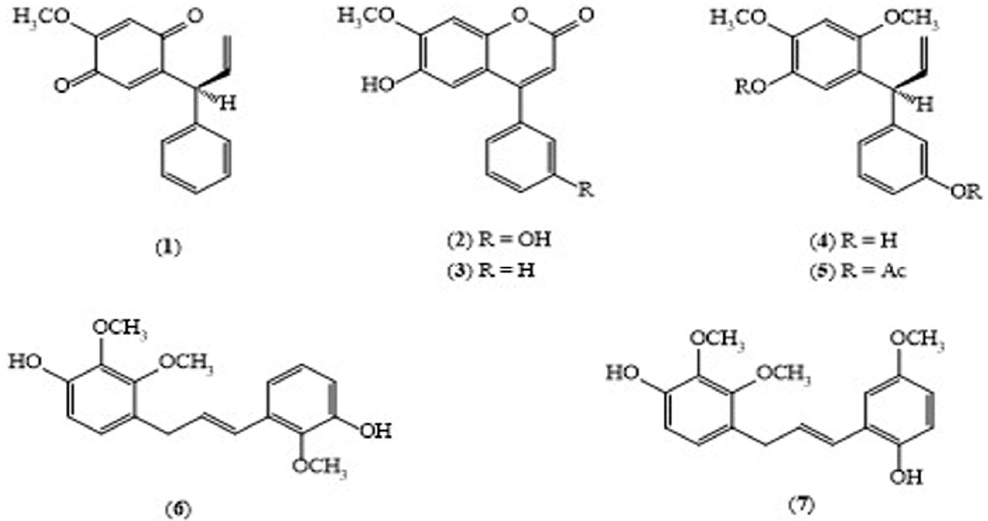
Figure 2. Structures of selected compounds isolated from Dalbergia culatrata .